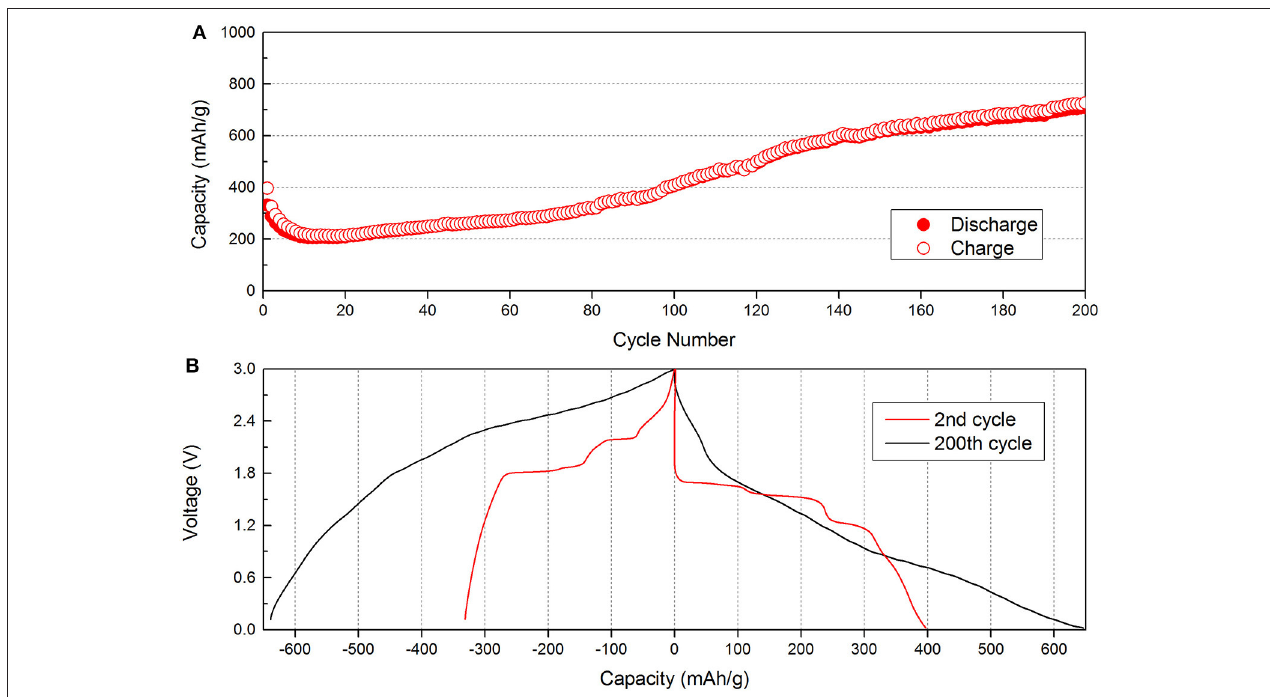
FIGURE 2 | Electrochemical performances of the Cu 2 Se electrode: (A) Cycling performance at a rate of 100mA g − 1 ; (B) the 2nd and 200th discharge/charge voltage